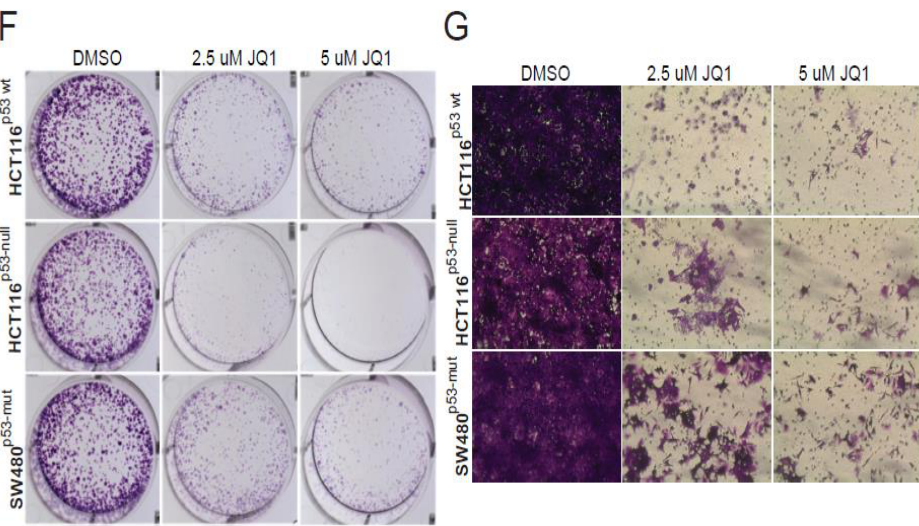
Figure 8. PAICS is Myc-dependent in CRC. Infections with lacZ control and Myc adenovirus in CRL1807 cells were performed followed by ( A ) qPCR analysis and ( B ) immunoblot analysis. ( C ) PAICS and Myc protein levels showed by Immunoblot analysis after Myc knockdown in HCT116 p53-wt , HCT116 p53-null , and SW480 p53-mut cells. ( D ) Immunoblot analysis of PAICS and C- Myc after JQ1 treatment of HCT116 p53-wt , HCT116 p53-null , and SW480 p53-mut cells. Cell proliferation ( E ), colony formation ( F ) , and invasion ( G ) were assessed after treatment of CRC cells with JQ1.